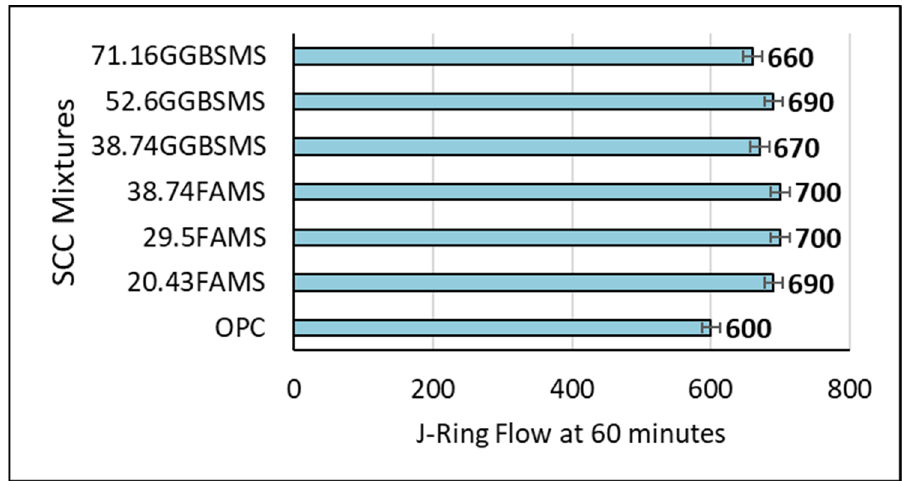
Figure 13. J-ring flow mm of SCC mixture.